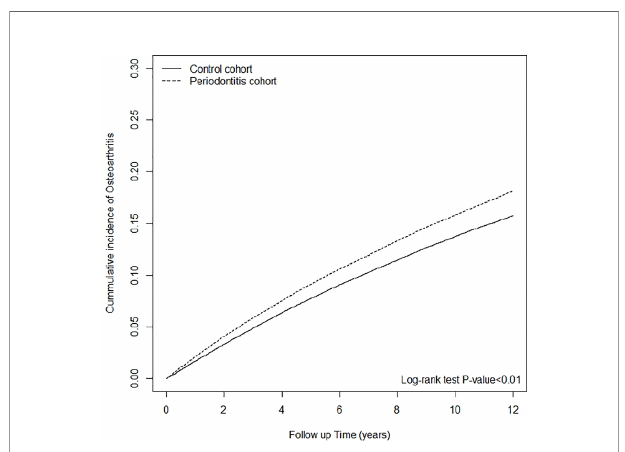
FIGURE 2 | Cumulative incidence of osteoarthritis in patients with and without periodontitis.